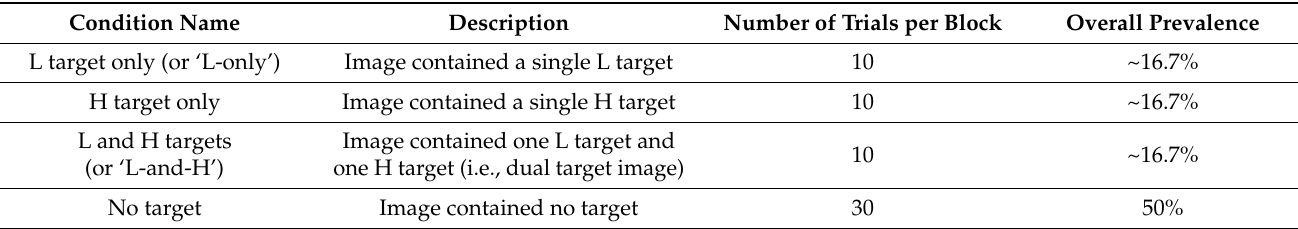
Table 1. The experimental conditions during SOS testing blocks in Experiment